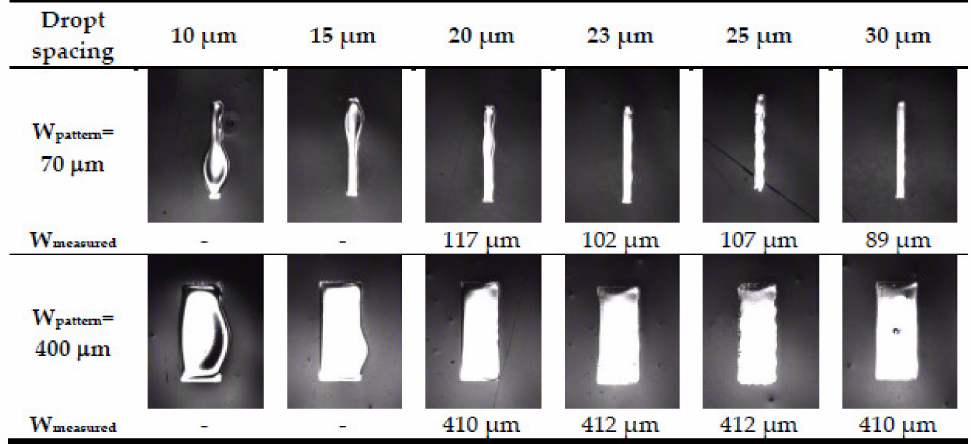
Figure 7. Optical photographs of silver films obtained with one-pass printing and a droplet spacing of 10–30 µ